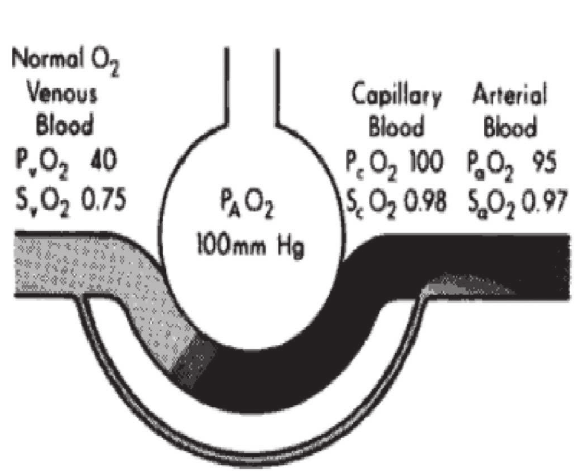
Fig. 4 - Dinâmica do sangue ao percorrer o capilar pulmonar, observa-se uma queda na PO venoso